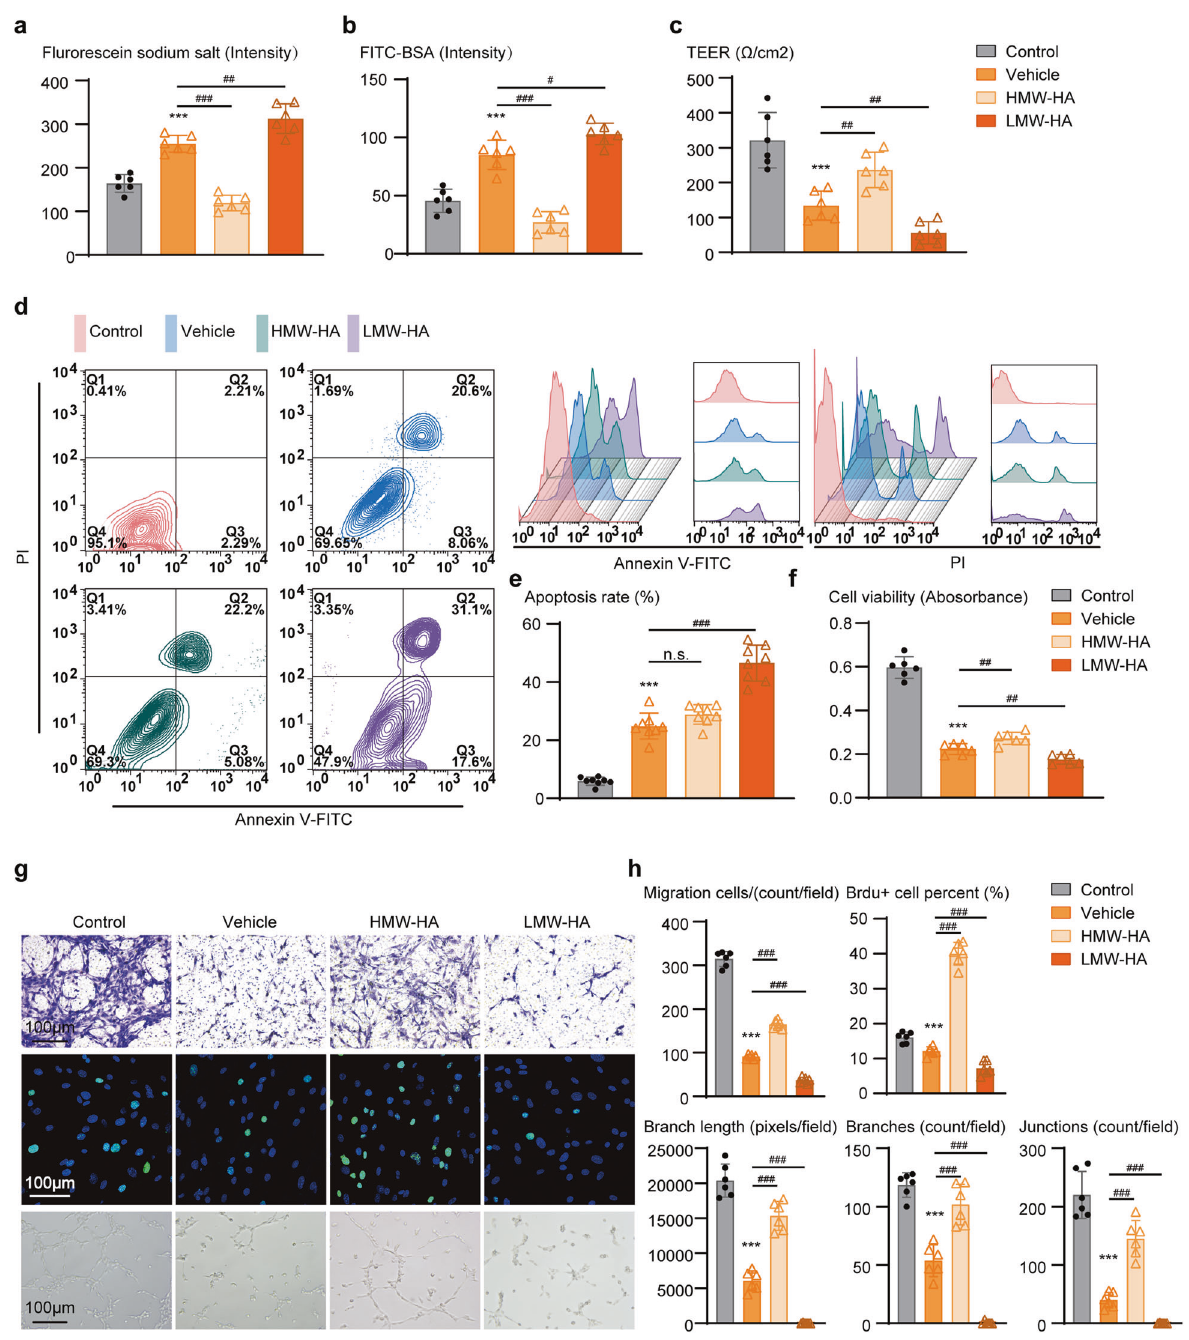
Fig. 5 Suppression and stimulation of FSAP impairs or promotes BBB integrity and angiogenesis in cultures of mouse brain microvascular endothelial cells (mBMECs) after OGD, respectively. a – c The paracellular permeability and Trans Endothelial Electrical Resistance (TEER) value were measured to re fl ect the barrier property of the mBMECs monolayer after OGD. a Quantitative analysis of the intensity of in fi ltrated fl uorescein sodium, b FITC-BSA, and c monolayer electrical resistance. Data is expressed as mean ± SD; n = 6 for each group; *** p < 0.001 versus control group, # p < 0.05, ## p < 0.01, ### p < 0.001 versus vehicle group by one-way ANOVA followed by Tukey ’ s multiple comparison tests. d – f Apoptotic cells were stained with annexin V-FITC and propidium iodide and analyzed using a FACS Calibur fl ow cytometer, and cell viability was measured by Cell Counting Kit-8. d Representative images of FACS analysis of apoptotic cells, e quantitative analysis of apoptotic rates, and f cell viability. Data is expressed as mean ± SD; n = 6 for each group; *** p < 0.001 versus control group, n.s. not signi fi cant, ## p < 0.01, ### p < 0.001 versus vehicle group by one-way ANOVA followed by Tukey ’ s multiple comparison tests. g Representative images of transwell migration assays, BrdU incorporation assays, and tube formation assays, and h quantitative analysis of migration cells, proliferative cells, branch length, branch counts, and junction counts. Data is expressed as mean ± SD; n = 6 for each group; *** p < 0.001 versus Control group, ### p < 0.001 versus Vehicle group by one-way ANOVA followed by Tukey ’ s multiple comparison tests